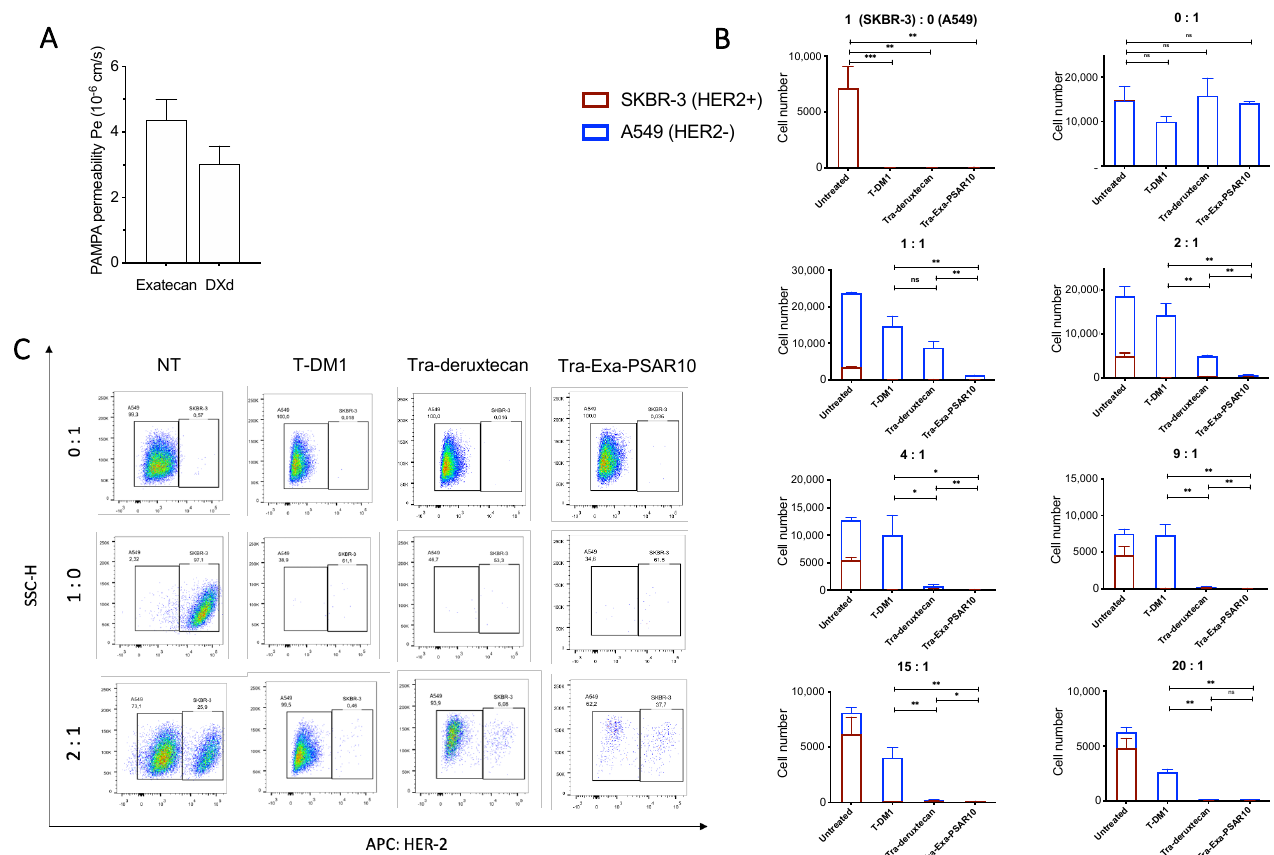
Figure 5. Bystander killing effect of Tra-Exa-PSAR10 compared to T-DM1 and trastuzumab-deruxtecan (DS-8201a) in co-culture in vitro. ( A ) Passive cell membrane diffusion of Exatecan and DXd payloads as assayed by a Corning ® Gentest TM PAMPA assay. ( B ) In vitro bystander killing effect of Tra-Exa-PSAR10 compared to Tra-deruxtecan in co-cultured SKBR-3 (HER2+) and A549 (HER2-) cells that were treated with 10 nM ADCs for 5 days. Cell number and ratio of HER2+ and HER2- cells were determined by flow cytometry. T-DM1 (Kadcyla ® ) was used as a negative control. ( C ) Representative flow cytometry data presented for 0:1, 1:0 and 2:1 cell ratio, showing no impact of the ADCs on HER2- A549 cells (0:1), activity against HER2+ SKBR-3 cells (1:0) and a stronger bystander activity of Tra-Exa-PSAR10 compared to Tra-deruxtecan. ns: not significant, *: p < 0.05, **: p < 0.01, ***: p < 0.001). n =